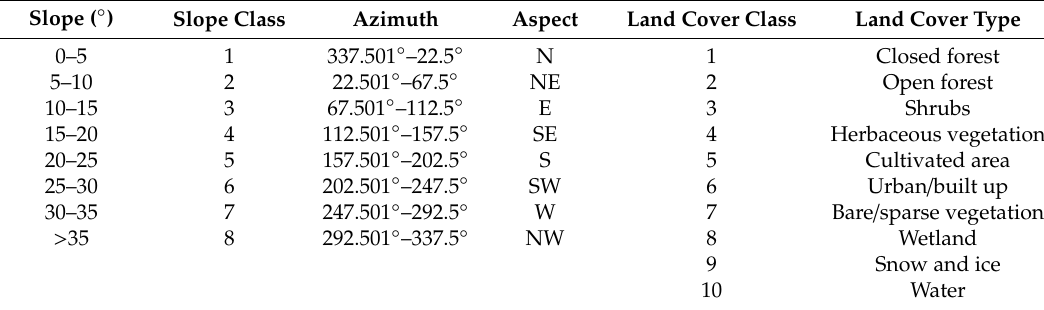
Table 2. Slope, slope aspect, and land cover classes used in the